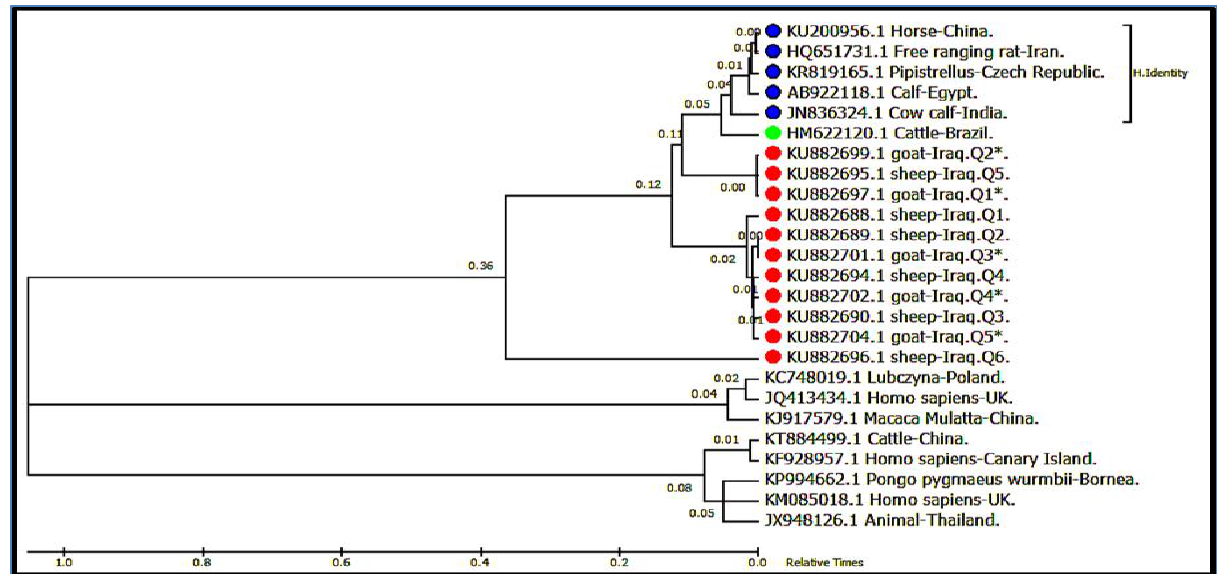
Figure, 3: Phylogenetic tree depend on the Neighbor joining tree method.The phylogenetic distances analyses were conducted by MEGA6. *Red spot: C. parvum strains isolated from Iraq. *Green spot: Strain high homologous with Iraqi – C. parvum isolated from sheep and goat. *Blue spot: Strains highly identity with Iraqi – C. parvum isolated from sheep and goat.